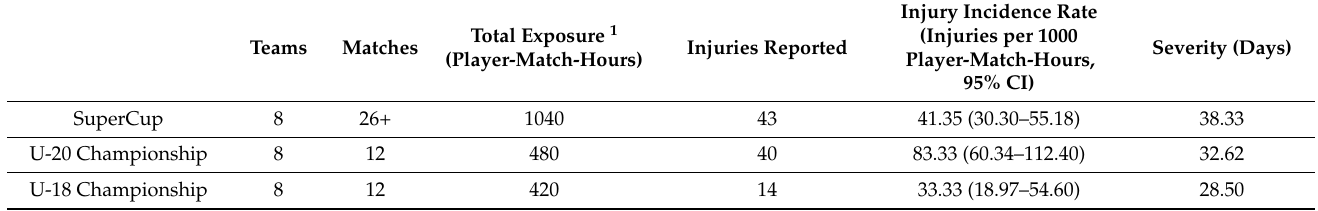
Table 1. Exposure, injury incidence, and severity in Rugby Europe competitions.